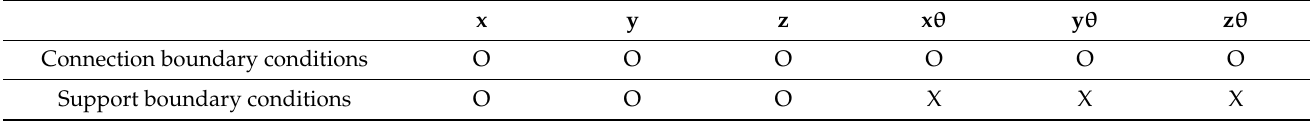
Table 13. Boundary conditions of structural analysis model.